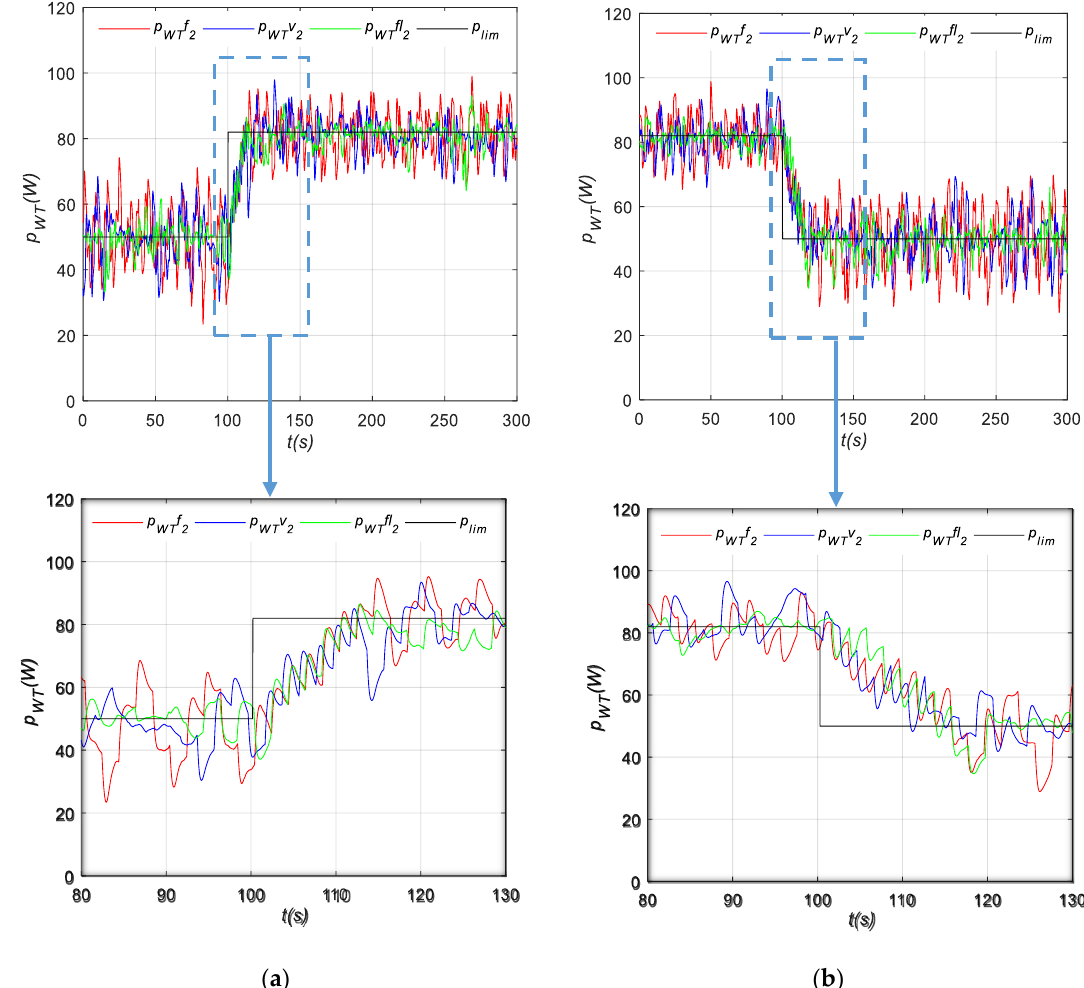
( b ) P . Figure 17. Drop in power: ( a ) sudden increase of P li m